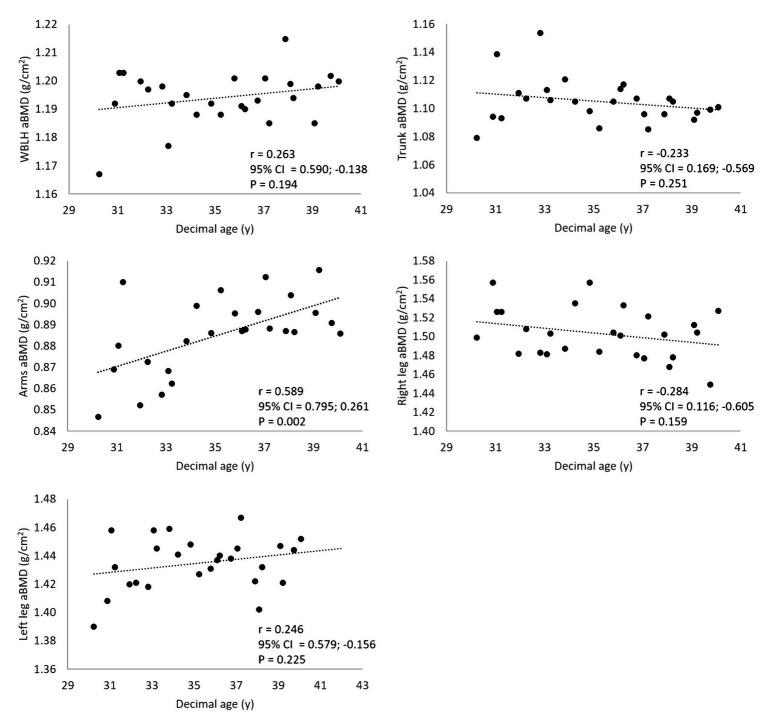
Scatterplots of aBMD at several skeletal sites plotted against age. 95% CI = 95% upper and lower CIs.